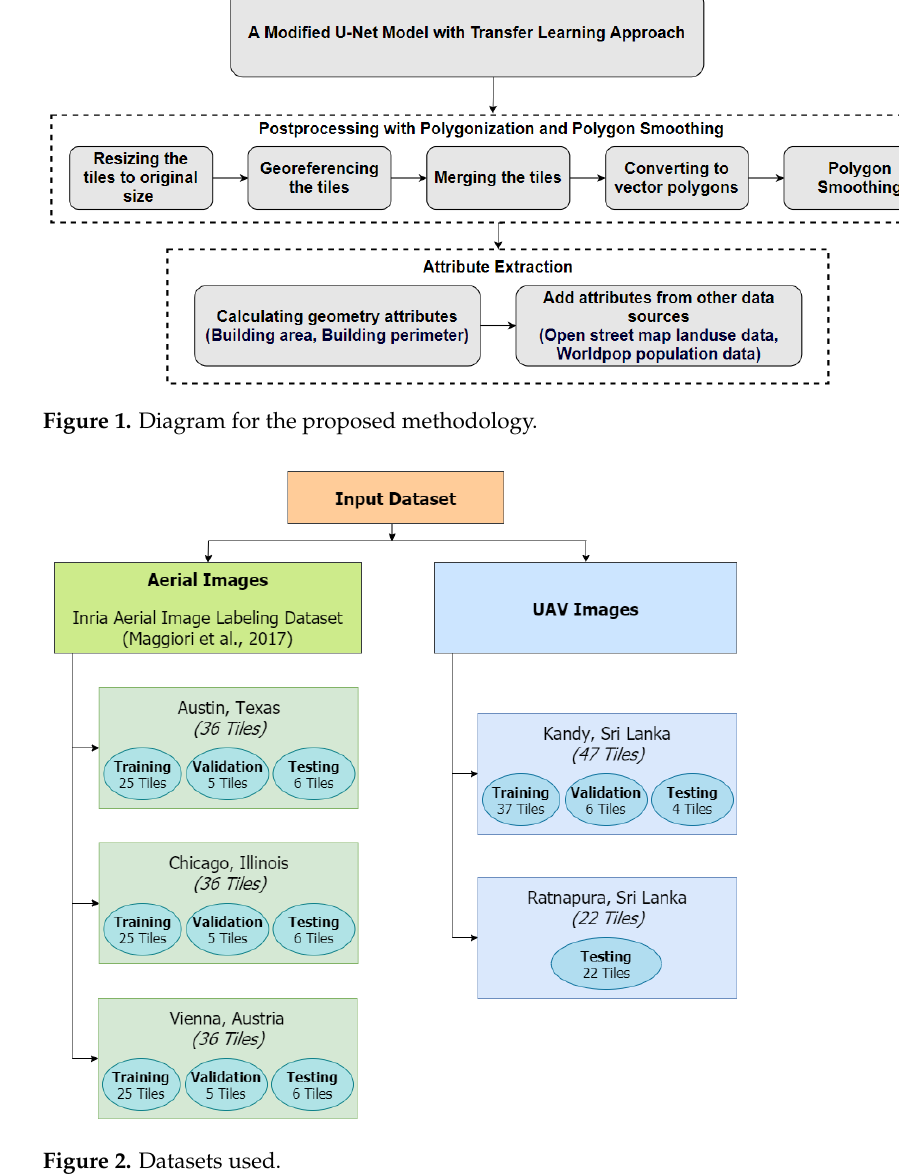
Figure 1. Diagram for the proposed methodology.